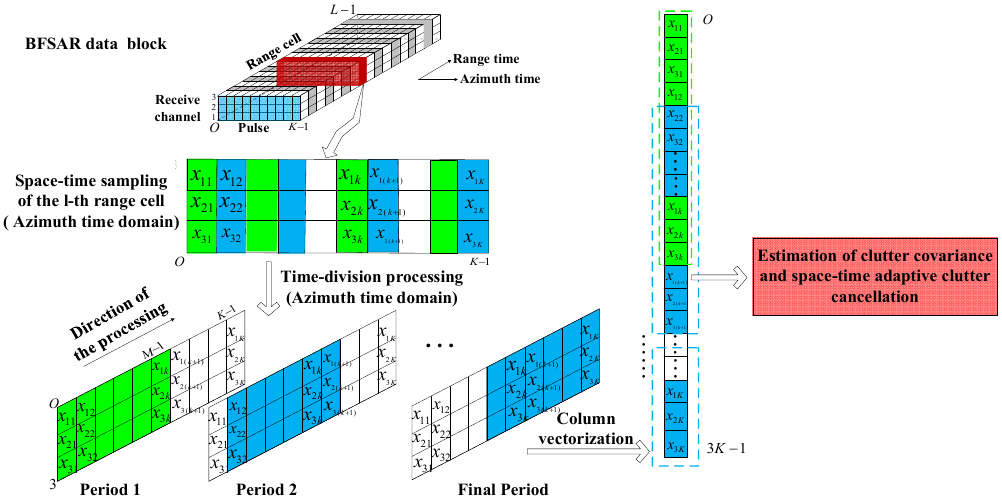
Figure 2. The procedure of first clutter cancellation in SAR echo domain.